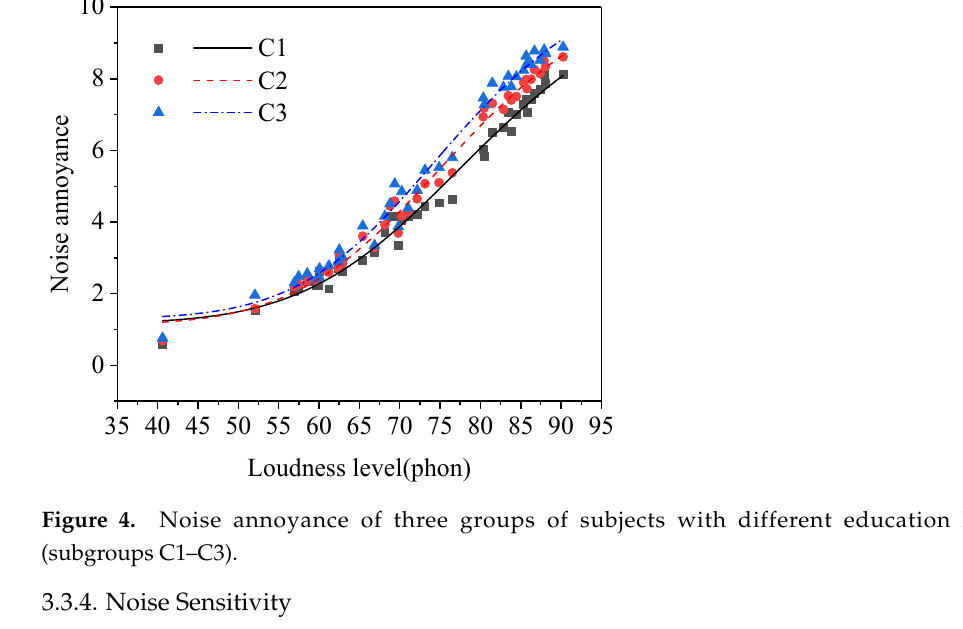
Loundness level(phon) Figure 3. Noise annoyance of three groups of subjects with different ages (subgroups A1–A3). 3.3.2. Gender The result of the paired samples t -test between the noise annoyance of male and fe- male groups was shown in Table 2. As shown in Table 2, there was not a significant dif- ference between the noise annoyance of subgroup B1 (male) and subgroup B2 (female). The subjects’ gender had no significant influence on noise annoyance, which was con- sistent with the research results from Miedema [1], Janssen [24], and Qu [25] et al. 3.3.3. Education Level The results of the paired samples t -test between the noise annoyance of different ed- ucation level groups were shown in Table 2. As shown in Table 2, there was a significant difference between the noise annoyance of any two groups in the three groups of subjects with different education levels (subgroups C1–C3). Noise annoyance increased with the rose of the subjects’ education level (see Figure 4), which was consistent with the research